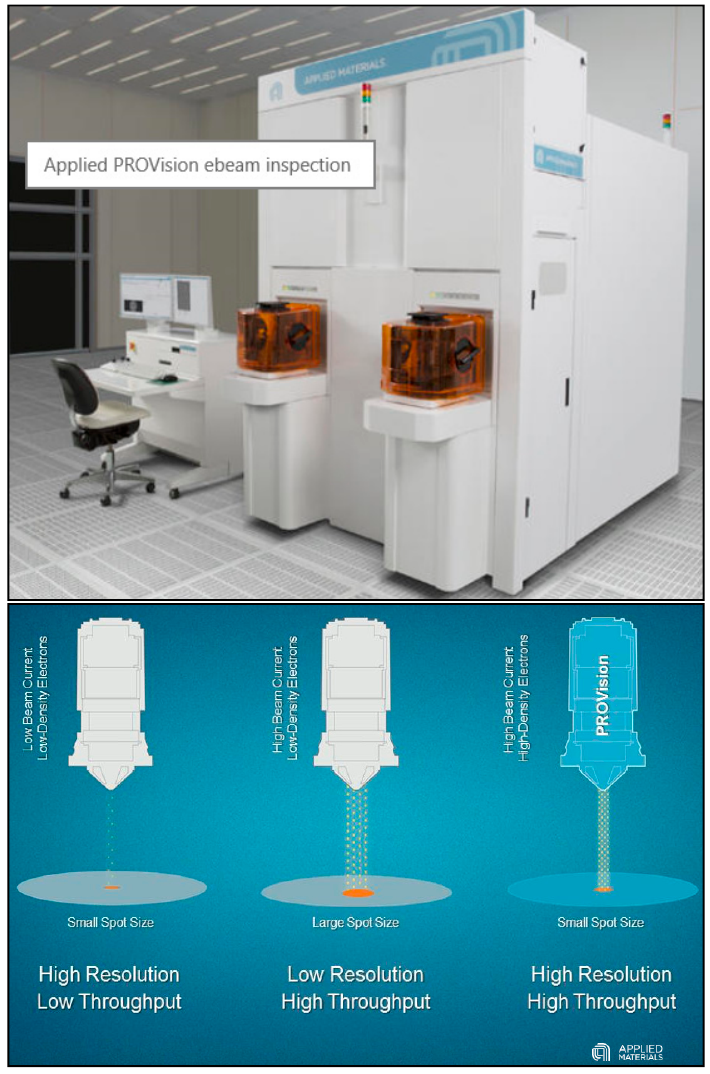
Figure 22. Applied Materials PROVision e-beam.